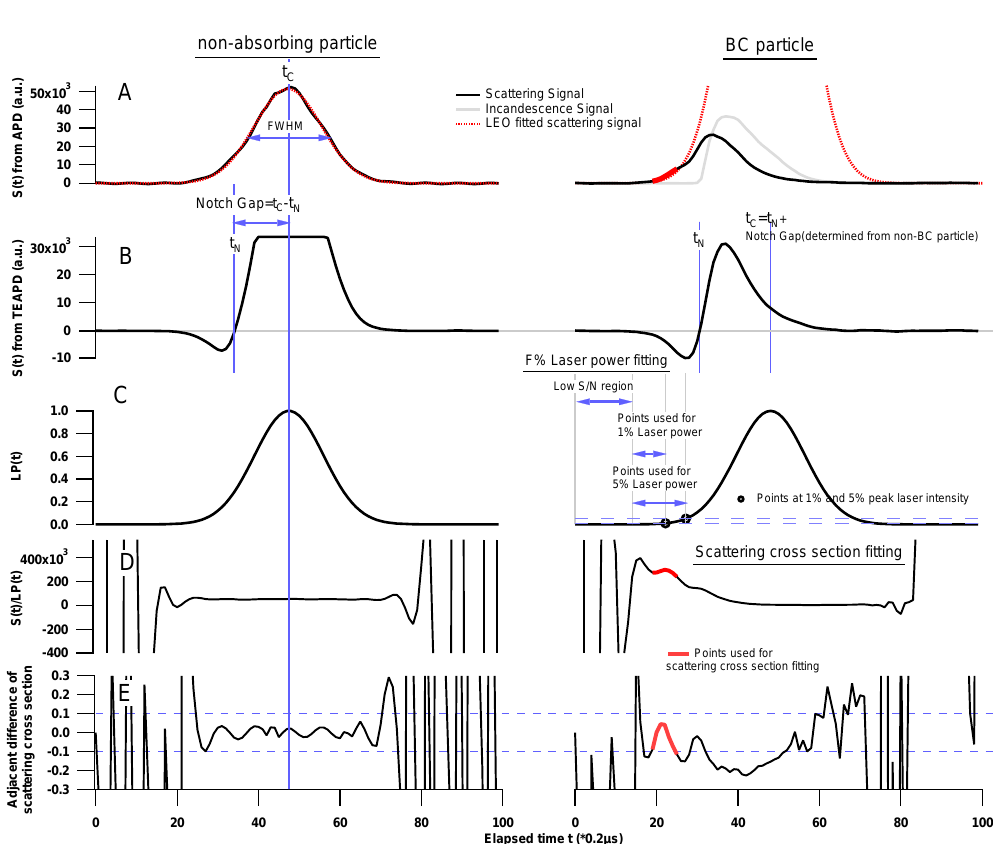
Figure B1. The methodology of leading edge only (LEO) Gaussian fitting. The left panel is a typical example of a single particle event for a non-absorbing particle and the right panel is for an absorbing BC particle. (a) The black line is the measured raw scattering signal S(t) from APD as a function of elapsed time t , the t C is when the peak S(t) occurs at the laser beam centre, the red dot line is the LEO fitted signal, with the grey line on the right panel showing the incandescence signal of the BC particle; (b) the two-element APD (TEAPD) signal used to determine the notch position t N (the zero-crossing point) and the notch gap t C − t N ; (c) the laser profile LP( t ) as determined by the σ and t C , with the blue double-end arrows showing the data points used for the “F% laser power” fitting method, the data points up to 1 and 5% peak laser intensity are shown; (d) the relative scattering cross section σ s (t) = S(t)/ LP (t) ; (e) the adjacent difference of σ s (t) calculated as ( σ s (t) − σ s (t − 1 ))/σ s (t) . The thick red lines on panel (a) , (d) and (e) show the data points used for scattering cross section LEO